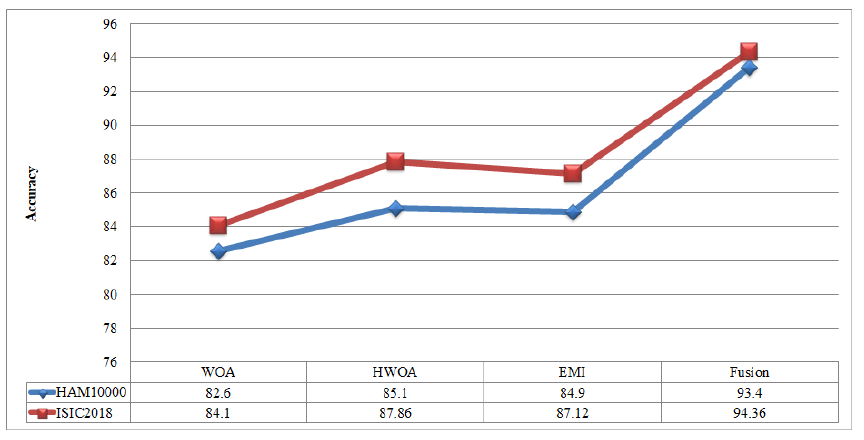
Figure 15. Comparison among original WOA with HWOA, EMI, and Fusion techniques .